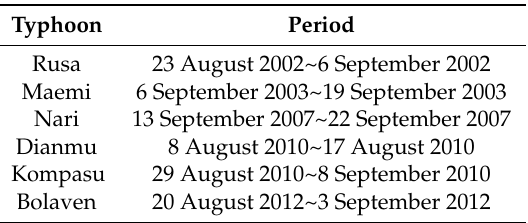
Table 2. Selected six